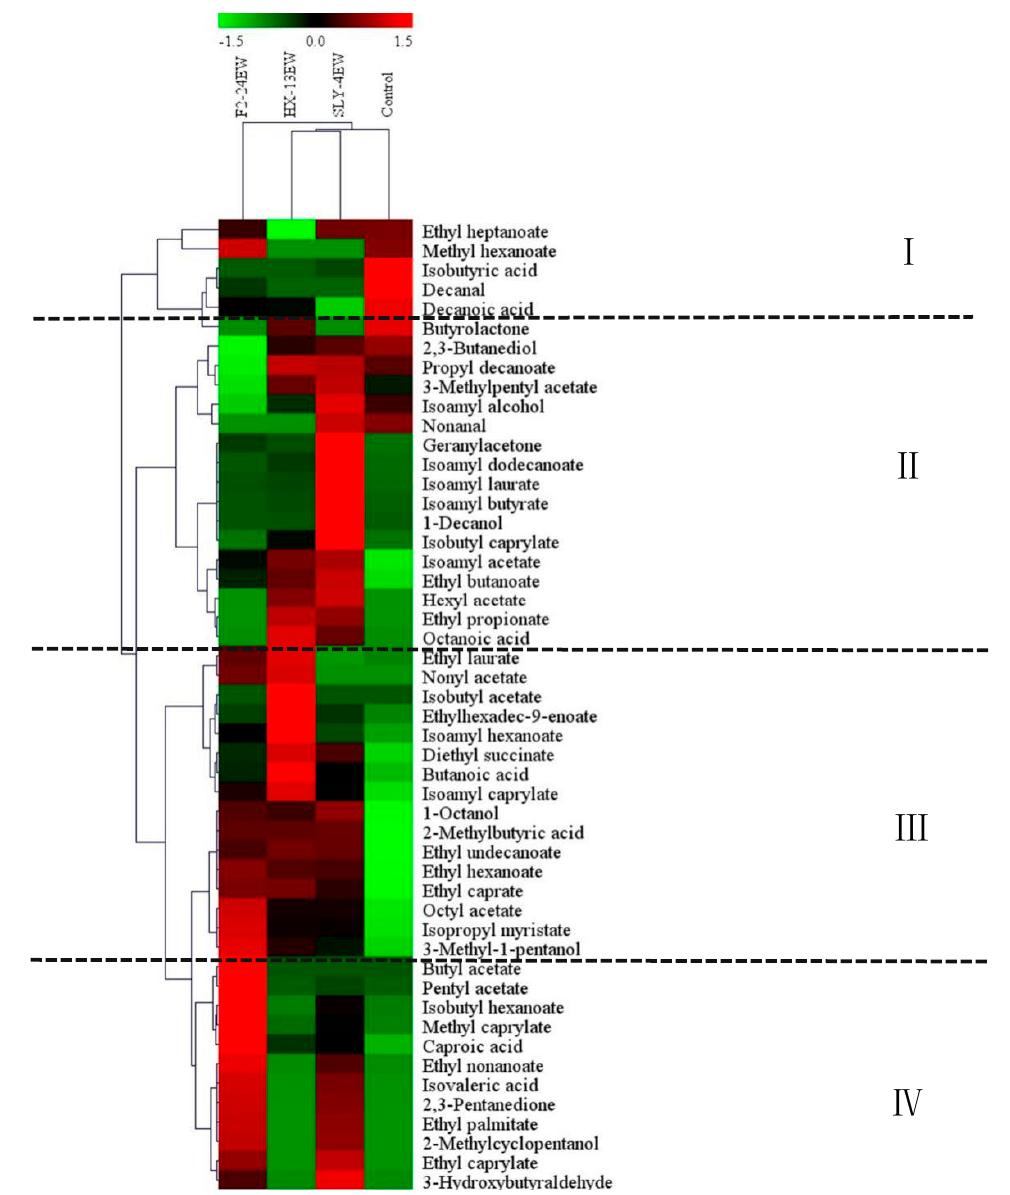
Figure 3. Hierarchical clustering and heat map visualization of fermentative aroma compounds from wines treated by crude β - glucosidase from different non- Saccharomyces yeasts. SLY-4EW: Wines treated by crude β -glucosidase from I. terricola SLY-4; F2-24EW: Wines treated by crude β -glucosidase from P. kudriavzevii F2-24; HX-13EW: Wines treated by β -glucosidase from M. pulcherrima HX-13; Control: Wines without enzyme treatment. All the detected fermentative aroma compounds were clustered into four classes and designated as class I, II, III, and